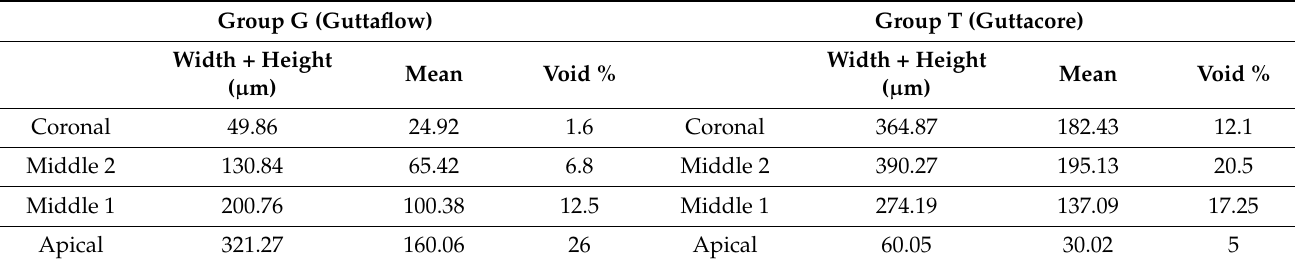
Table 1. Results table. the results show the values for group G and group T, respectively, in terms of the void dimensions, mean value, and percentage value in their respective four points analyzed: coronal, mean 2 mean 1 and